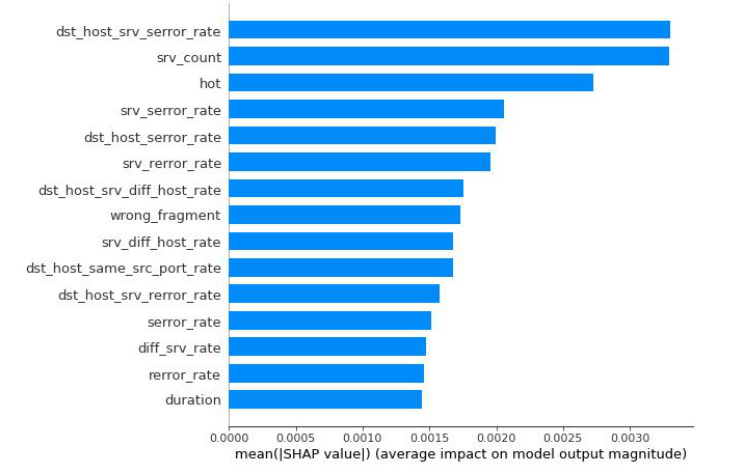
Figure 5. Bar graph of SHAP values calculated for the NSL-KDD dataset using the EIF model of the MemAE-EIF algorithm.